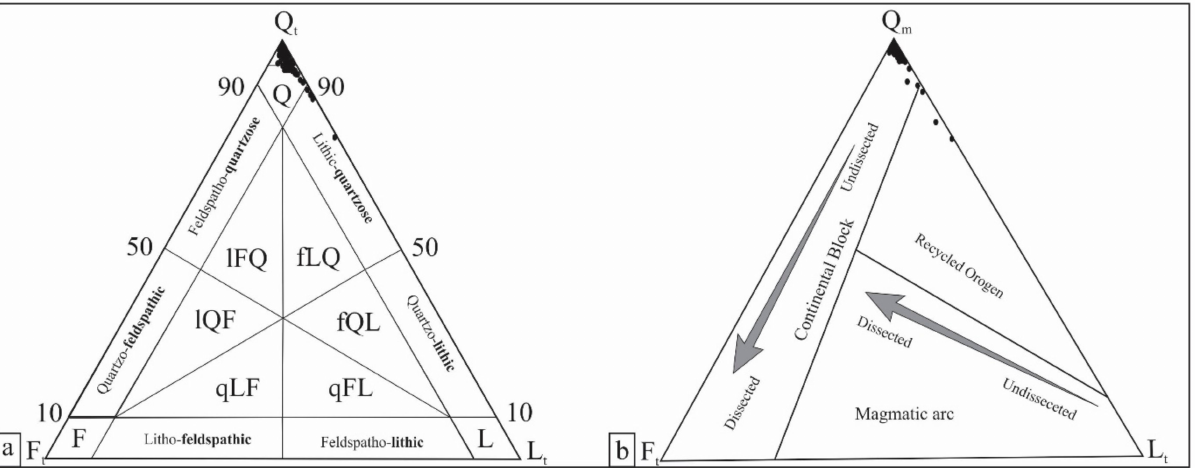
Figure 8. ( a ) Total Quartz–Feldspars–Lithics (Q t F t L t ) plot for the sandstone’s classification [62], showing that ma- jority of the sandstones are pure quartzose: Q = quartzose (qQ = pure quartzose); F = feldspathic; L = lithic; FQ = feldspatho-quartzose (fFQ = feldspar-rich; qFQ = quartz-rich); QF = quartzo-feldspathic; LF = litho-feldspathic; FL = feldspatho-lithic; QL = quartzolithic; LQ = litho-quartzose; lFQ = litho-feldspatho-quartzose; lQF = litho- quartzo-feldspathic; qLF = quartzo-lithofeldspathic; qFL = quartzo-feldspatho-lithic; fQL = feldspatho-quartzo-lithic; fLQ = feldspatho-litho-quartzose; ( b ) Q m F t L t plot for tectonic setting discrimination [60], showing sediment derivation from undissected continental